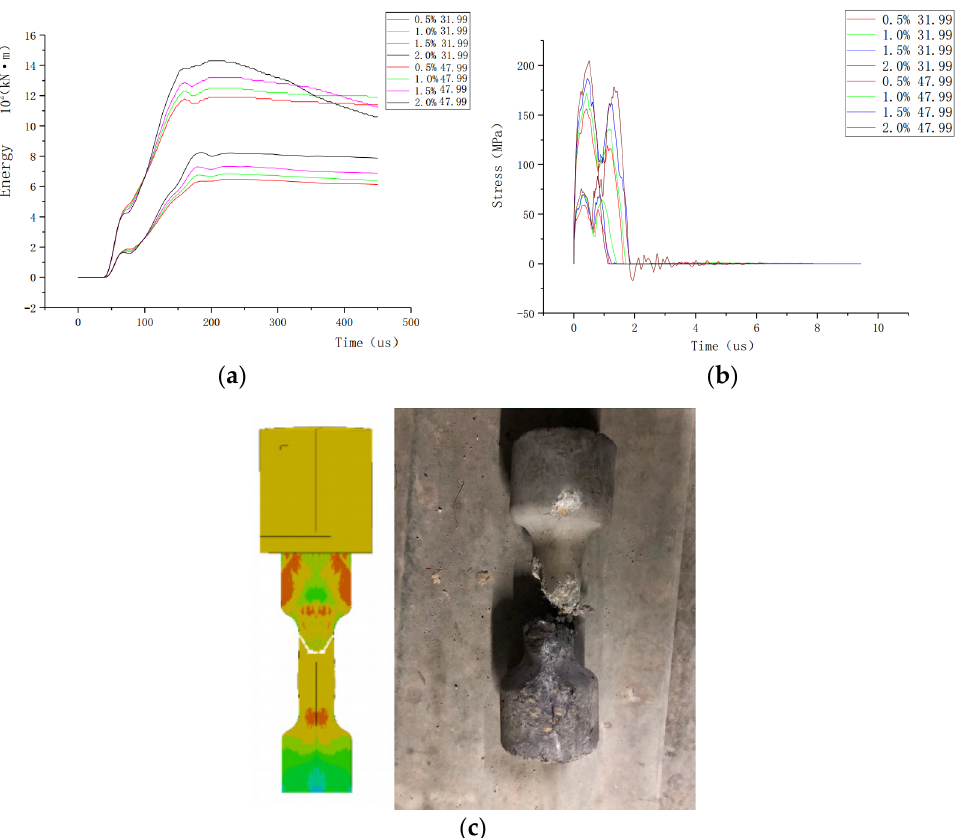
Figure 10. Simulation results of SFRC spindles under blast wave: ( a ) Energy time history curve ( b ) stress time history curve ( c ) Failure mode of 1.5% steel fiber reinforced concrete compared with simulation.